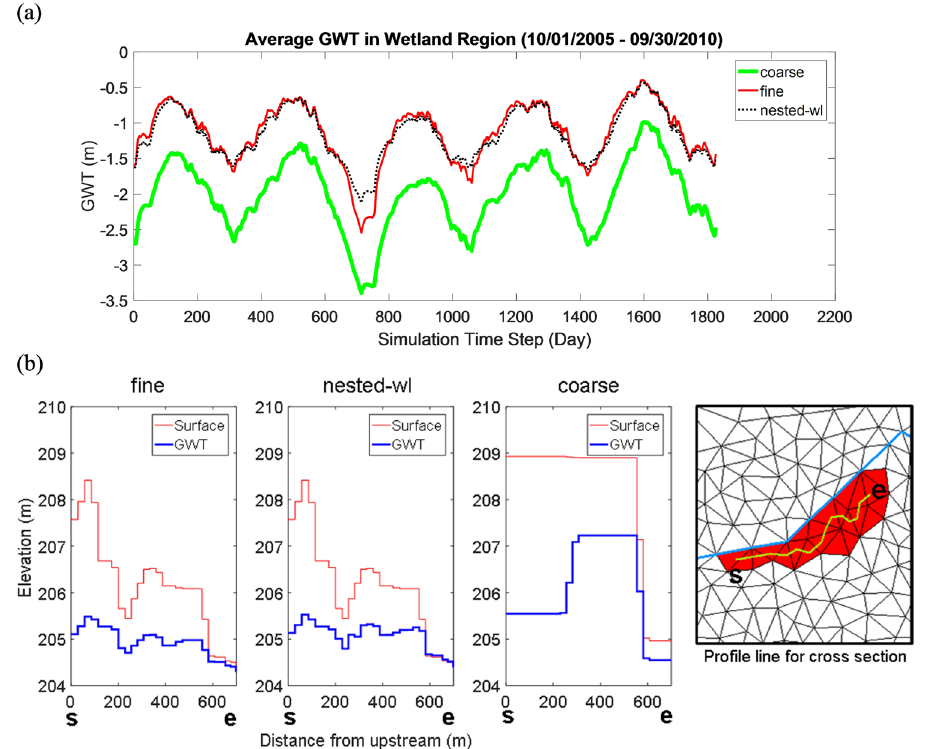
Figure 4. Model intercomparison of GWT estimates within the target wetland: ( a ) spatially averaged GWT variability, and ( b ) Surface topography and GWT profiles along a profile section within the wetland. The profiles were generated at the 17 th hour on the 520 th day. The profile line starts at s on the left and ends at e on the